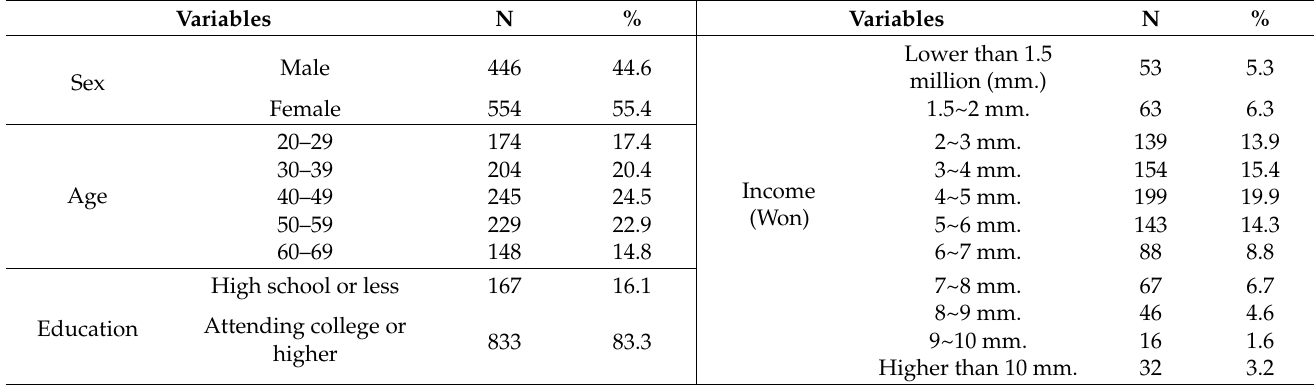
Table 7. Sociodemographic characteristics (N =